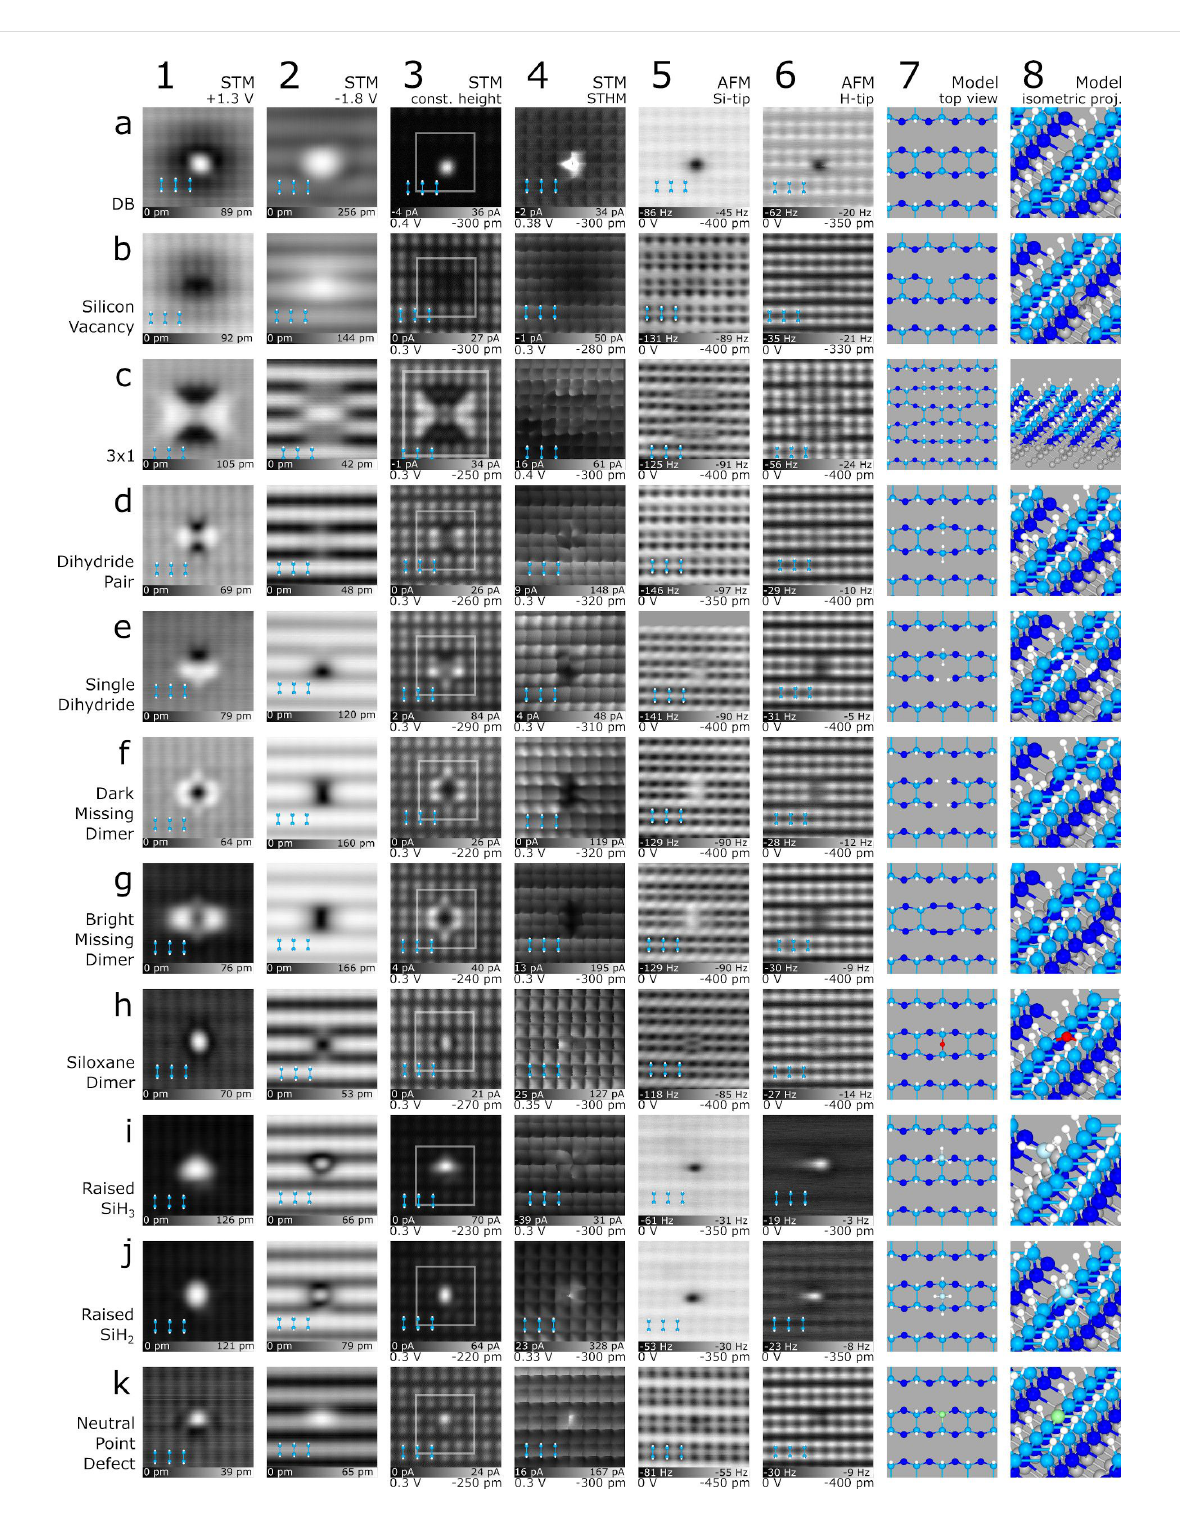
Figure 2: Common features of the H–Si(100)-2 × 1 surface imaged using the indicated STM and nc-AFM imaging modes. The identity of the features is listed on the left of the rows, with a ball and stick model of the dimer structure shown as an overlay in each scan (lower left corners, 0.77 nm width). The area of the structural models in column 7 is indicated by the grey box surrounding the defect in column 3. For the constant-height analysis types in columns 3–6, the applied constant bias value and relative tip–sample height are given in the lower left and lower right, respectively, of each frame. Colours in the ball and stick models are: H – white, Si dimers – royal blue, back-bonded Si – dark blue, O – red, raised Si – sky blue, and unknown species – green. Images are 3.2 nm × 3.2